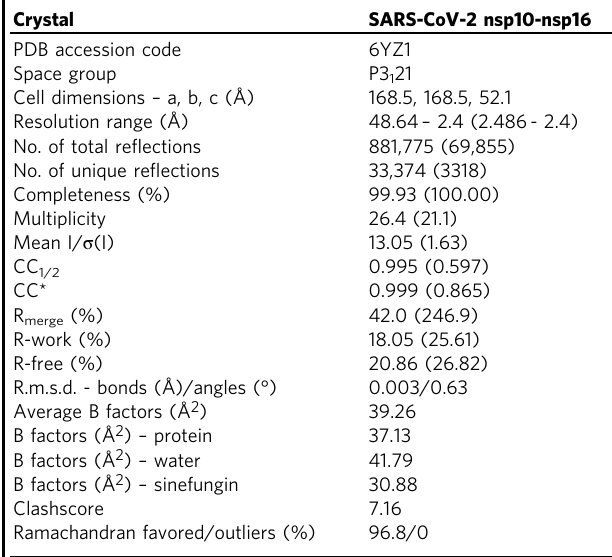
Table 1 Statistics of crystallographic data collection and re fi